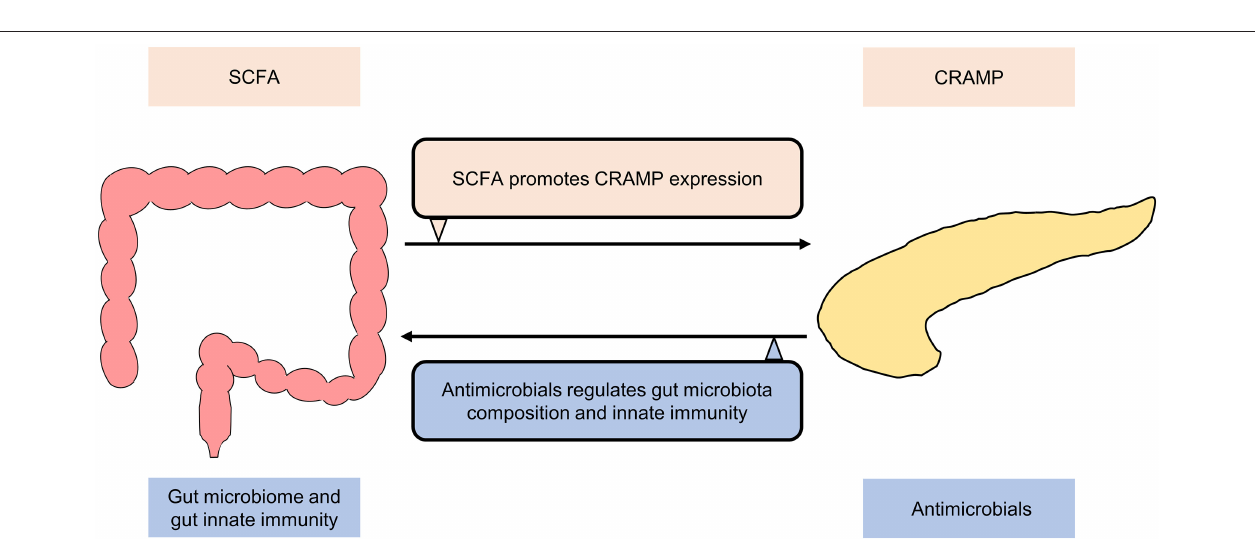
of pancreatic ductal adenocarcinoma (PDAC) by driving the C3 cascade through activating mannose-binding lectin